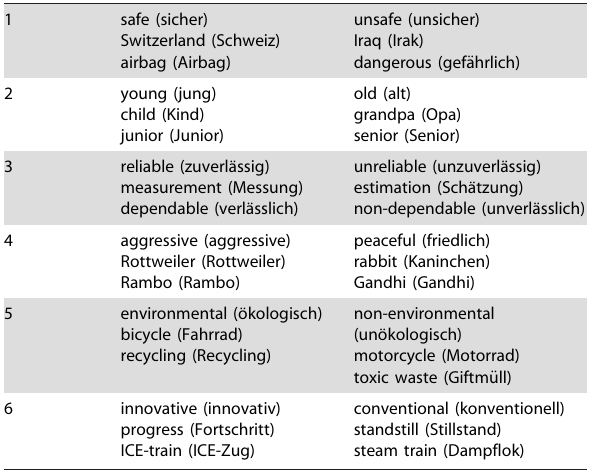
Table 1. Word stimuli for each category of the six bipolar attribute dimensions, translated into English (original German terms used in the study are given in parentheses).